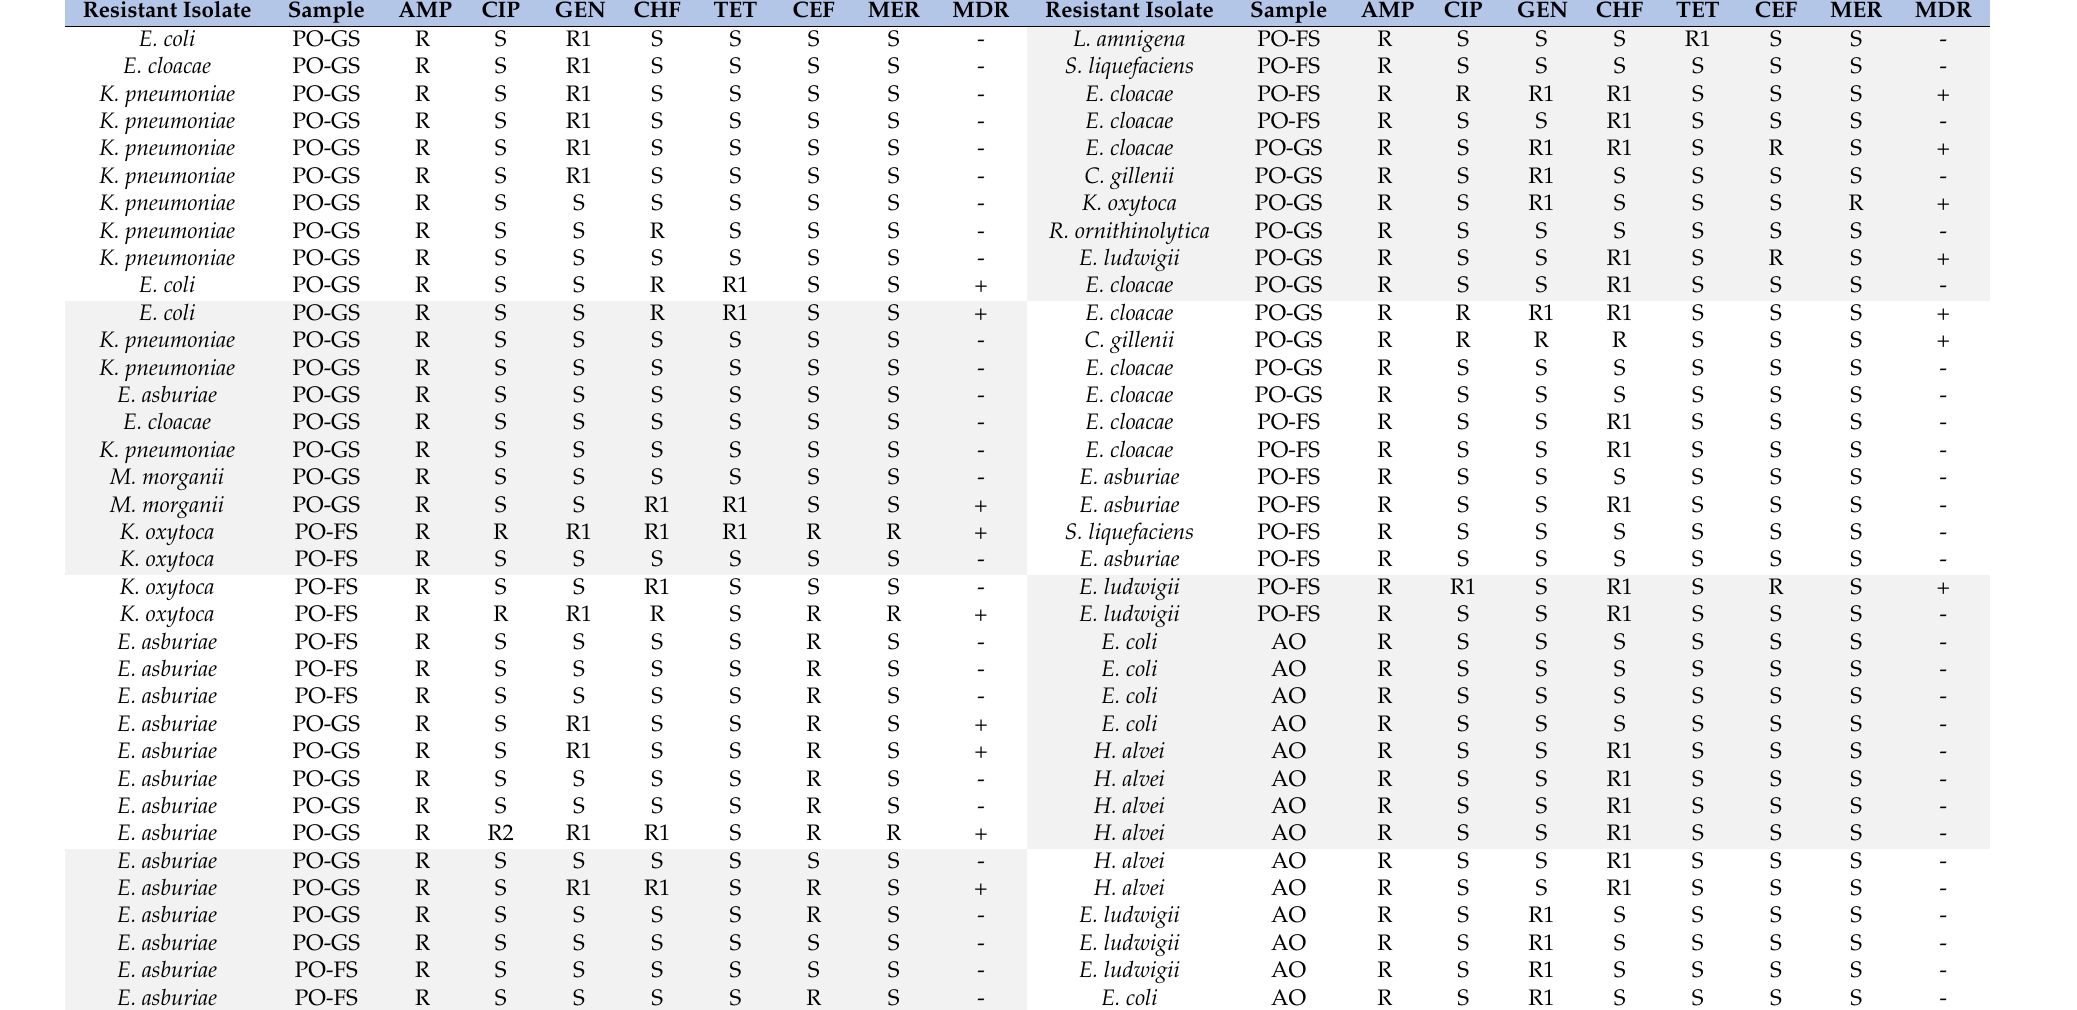
Table 3. Antibiotic susceptibility profile of coliform bacteria isolated from raw milk and smoothie